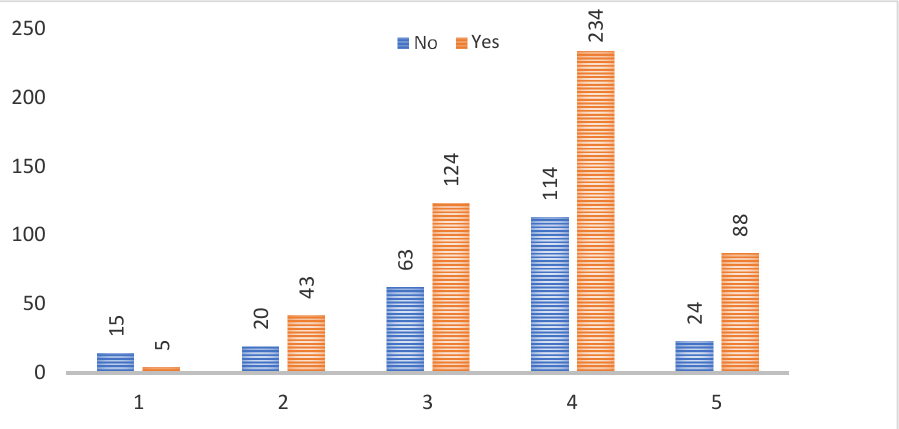
Figure 3. Distribution of respondents’ answers to the question regarding the practical work experience of the student (yes, no) and to “Do you consider yourself as an entrepreneurial person?” (1, no; 2, probably no; 3, neither yes nor no; 4, rather yes; 5, yes).